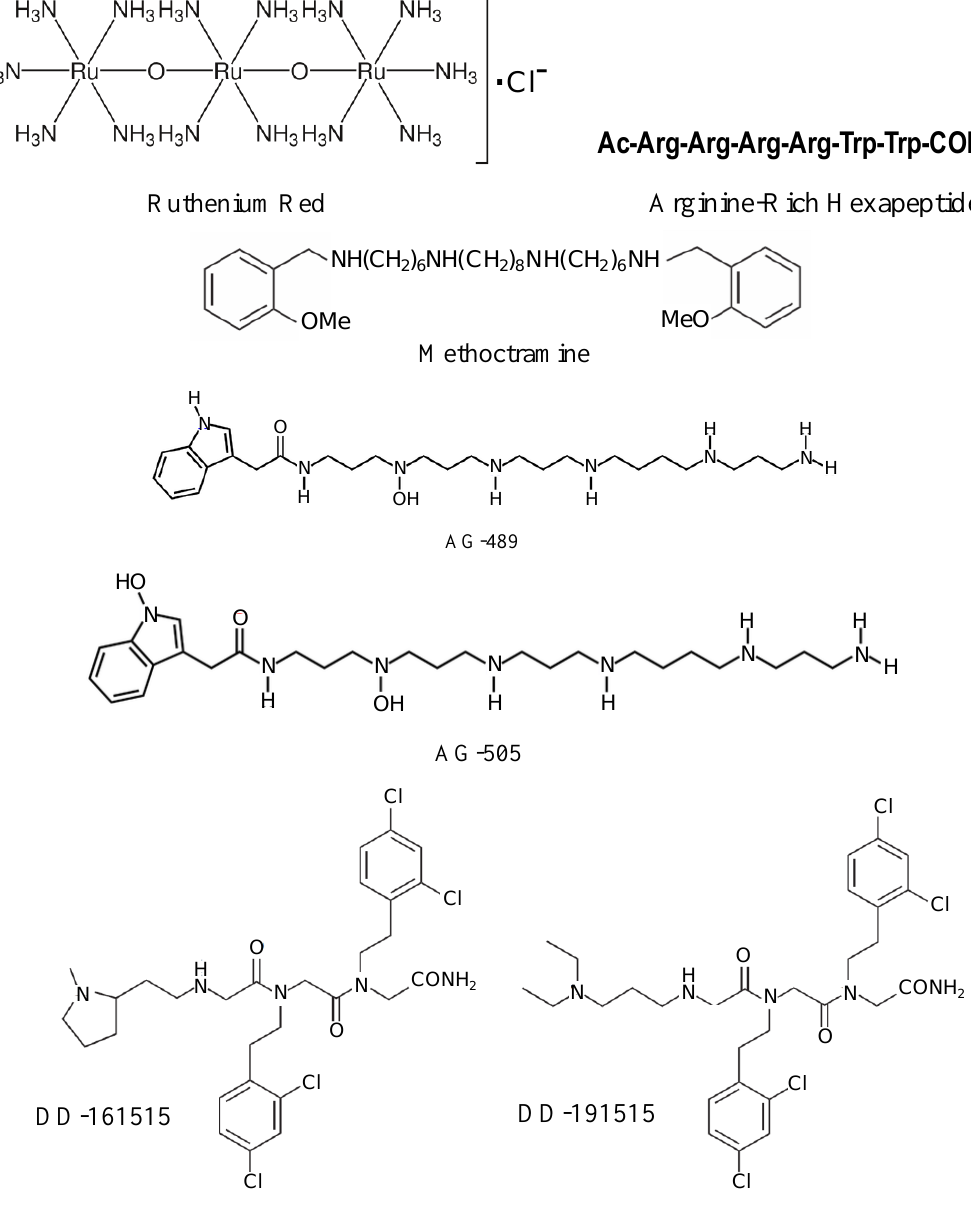
Figure 3. Chemical structures of non-competitive TRPV1 receptor